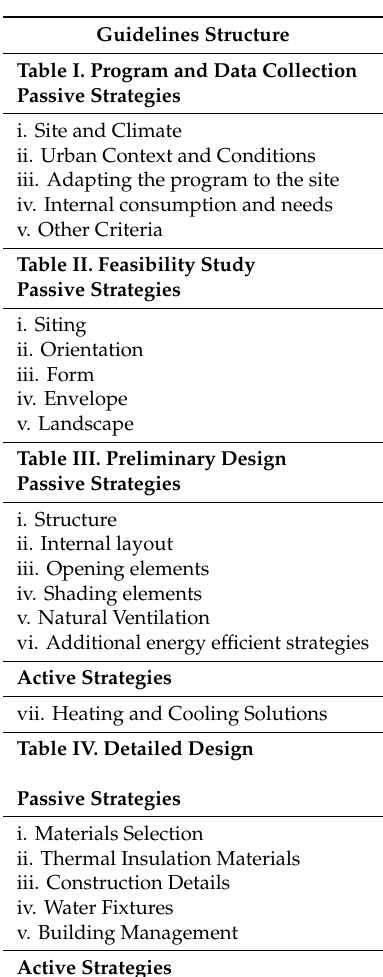
Table 2. Guidelines Structure.